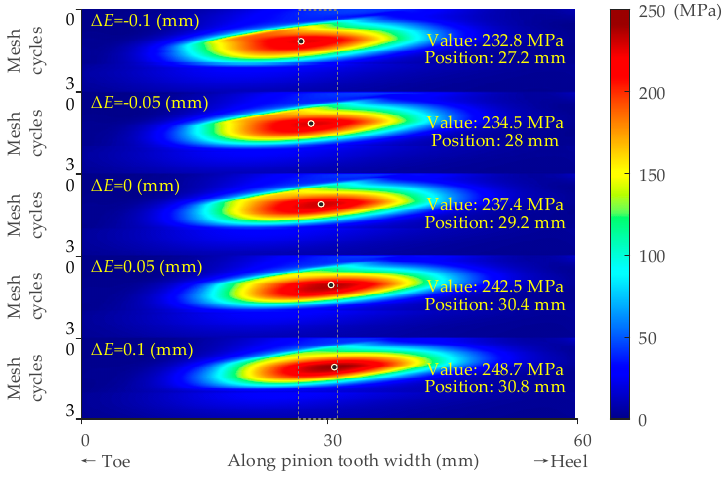
Figure 10. Variation of tooth root stress in three mesh cycles considering the variation of offset error.